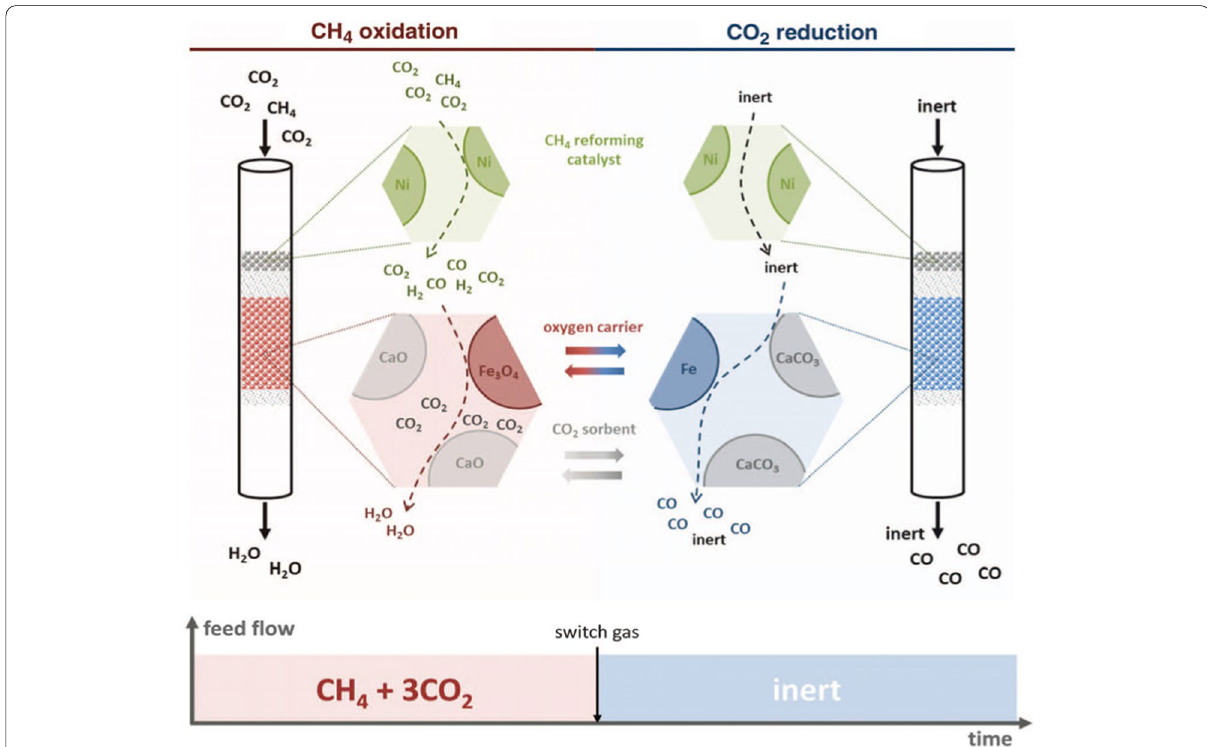
Fig. 18 Schematic representation of DMR with calcium-looping